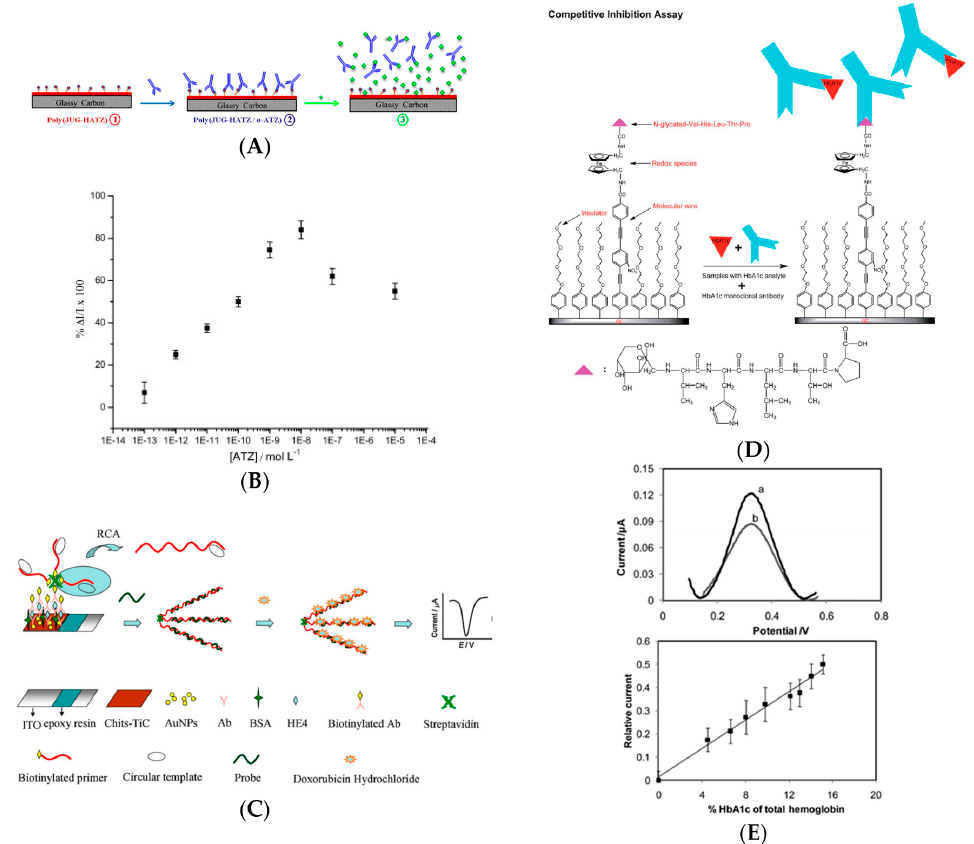
Figure 3. ( A ) Strategy for the electrochemical detection of atrazine based on the change in electroactivity of a polymer film poly(juglone-ATZ); (1) polymer/hapten-modified electrode; (2) after complexation with anti-ATZ; (3) after addition of ATZ in solution; ( B ) Calibration curve measured from SWV at − 450 mV/SCE, after addition of ATZ from 1 pM up to 10 µ M. Adapted from [22], Copyright 2012, with permission from Elsevier; ( C ) RCA-based immunosensor for HE4 detection. Reprinted from [26], Copyright 2012, with permission from Elsevier; ( D ) Scheme of the competitive inhibition assay for detecting HbA1c (anti-HbA1c: blue Y; HbA1c: red triangle; GPP: pink triangle, surface bound); ( E ) Above , a representative SWV for a FDMA-modified electrodes after (a) grafting of GPP and (b) incubation in 2 µ g mL − 1 anti-HbA1c and 13.5% HbA1c. Below, corresponding calibration